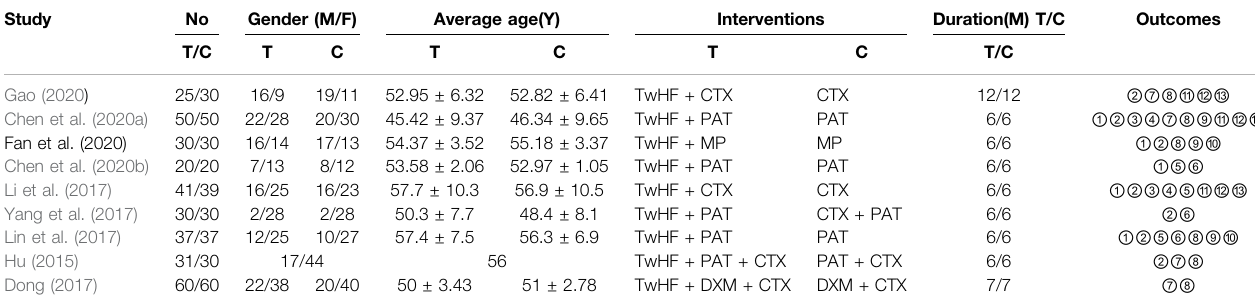
TABLE 1 | The characteristics of the included trials.